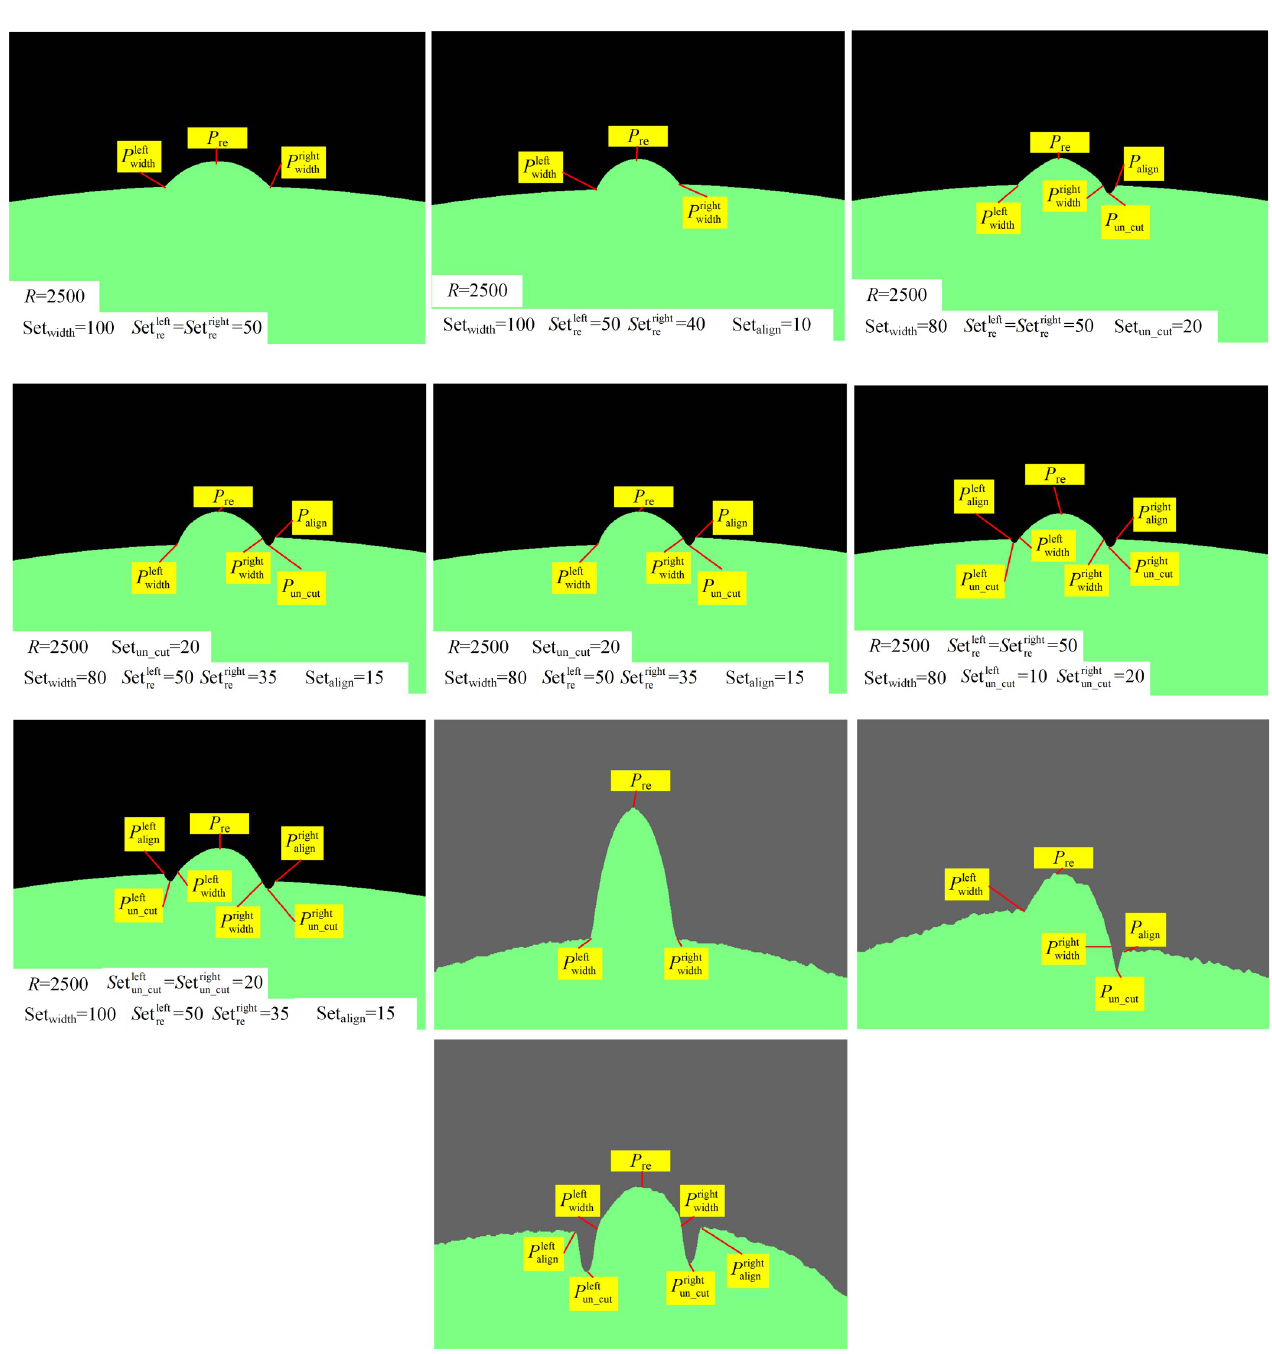
Fig 12. Acquisition of contour images to conduct simulations to generate contour images. (a) No defect parameter welds profile data set D 3 . (b) Weld profile data set D 3 for parameter simulation of defects with a single misalignment error. (c) Weld profile data set D 5 for parameter simulation of single undercut defect. (d) Weld profile data set D 5 for parameter simulation of undercut and misalignment defect parameters. (The undercut is on the misalignment side.) (e) Weld profile data set D 5 for parameter simulation of undercut and misalignment defect parameters. (The undercut is not on the misalignment side.) (f) Weld profile data set D 7 with parameter simulation of undercut defects on both sides. (g) Weld profile data set D 7 for simulation of the misalignment and undercut parameters on both sides (h) Actual collection data set D 3 . (j) Actual collection data set D 5 . (j) Actual collection data set D 7 .